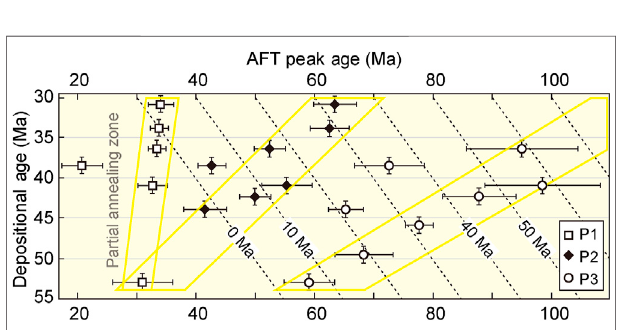
FIGURE 5 | Lag time plot of detrital AFT age components. Error bars are ± 1 σ for AFT ages and ± 1 Ma for depositional ages. The dashed lines are lag time contours, and the corresponding lag times arelabelled.Rectangles in yellow indicate the age variation of grouped populations, in which the AFT peak ages of P1, P2, and P3 all young with increasing depositional age.